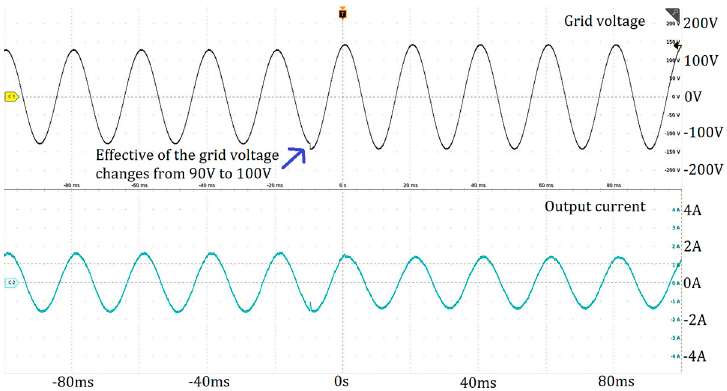
Figure 11. Responses of the grid-connected inverter when the grid voltage changes its effective value from 90 V to 100 V.